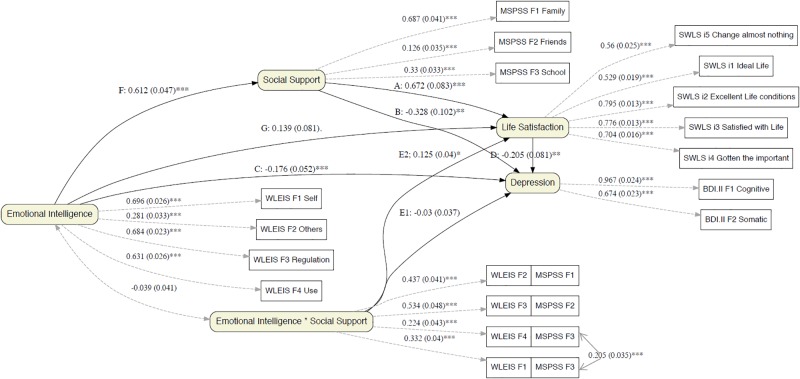
General structural model of hypothesized effects of emotional intelligence on well-being measures. The diagram includes the definition of the set of measurement (latent), structural (regressions), and Residual. Each of the paths includes the most relevant estimates: The Standardized regression weights, the standard errors (in brackets), and the signaling of those that are statistically significant (asterisks) at p < 0.05.